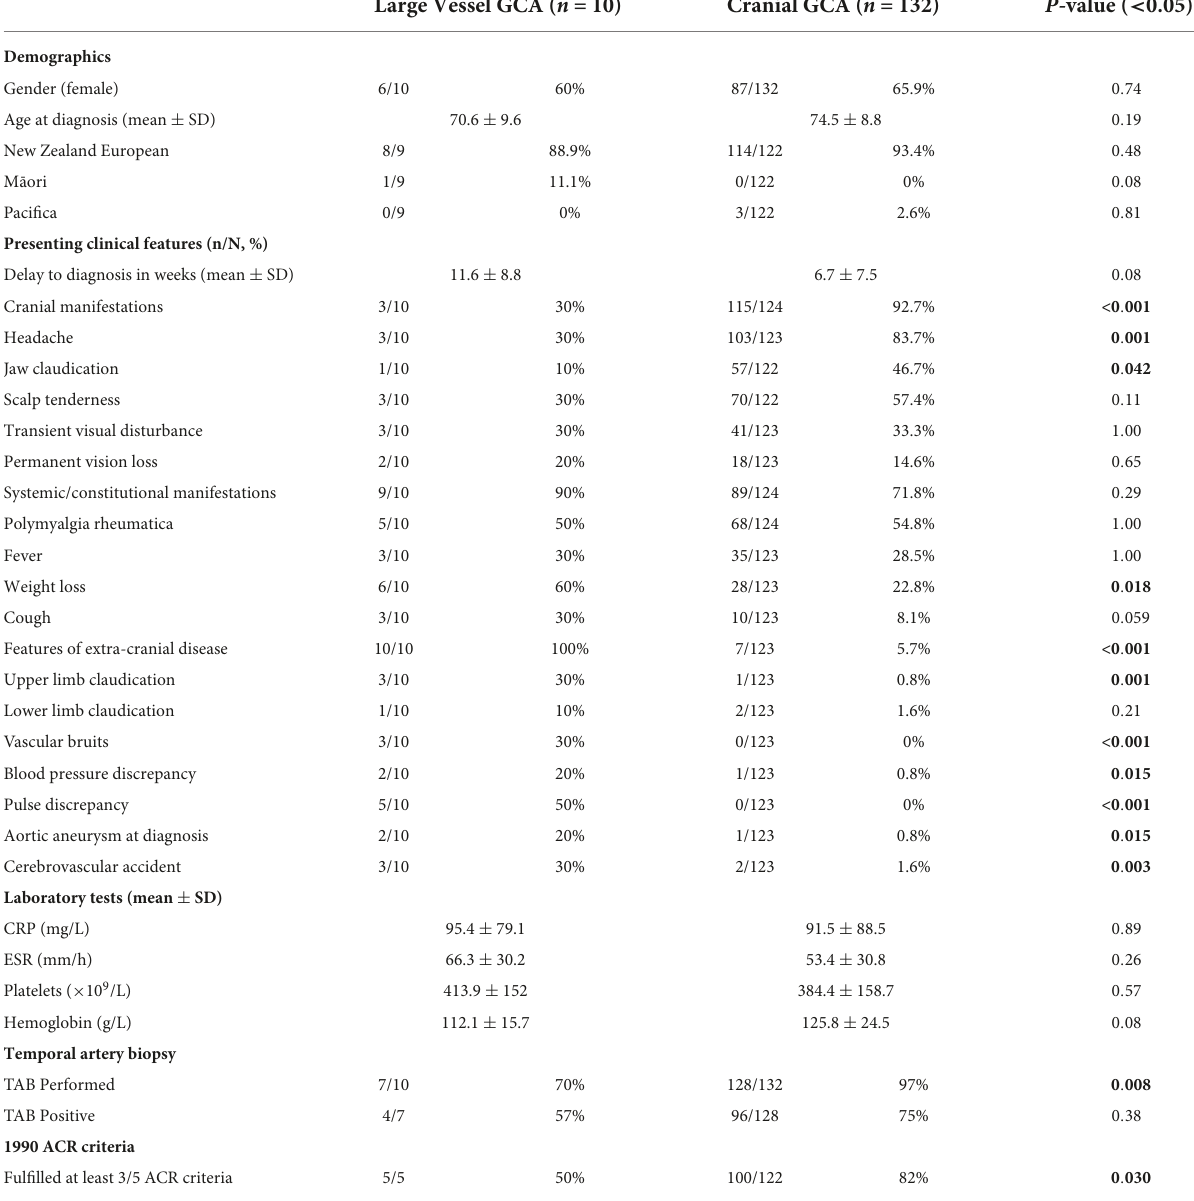
TABLE 1 Baseline characteristic of patients with limited cranial giant cell arteritis (GCA) compared to those with large vessel GCA. Large Vessel GCA ( n = 10) Cranial GCA ( n = 132) P -value ( <